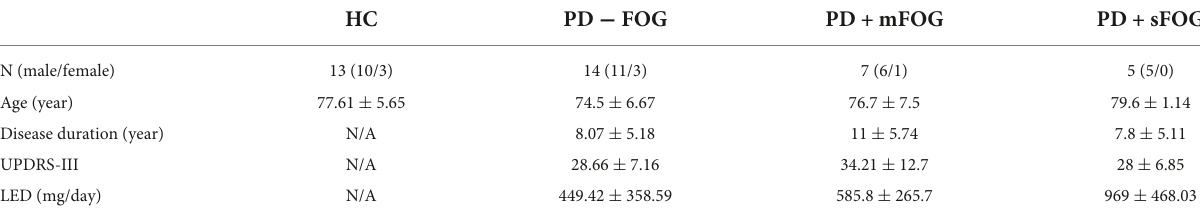
TABLE 1 Mean ± standard deviations for participant demographics and clinical